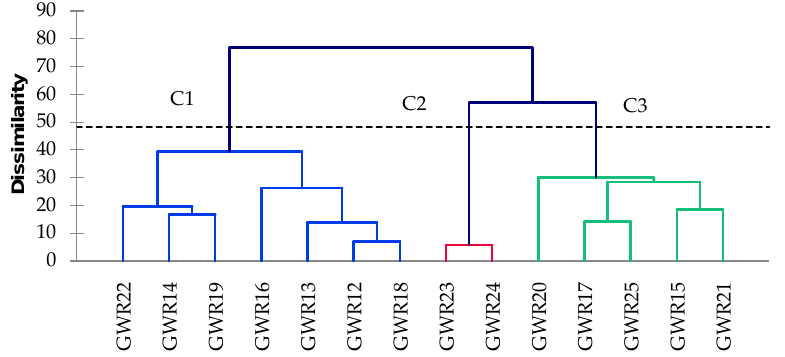
Figure 5. Dendrograms classifying the groundwater samples based on the chemical composition.